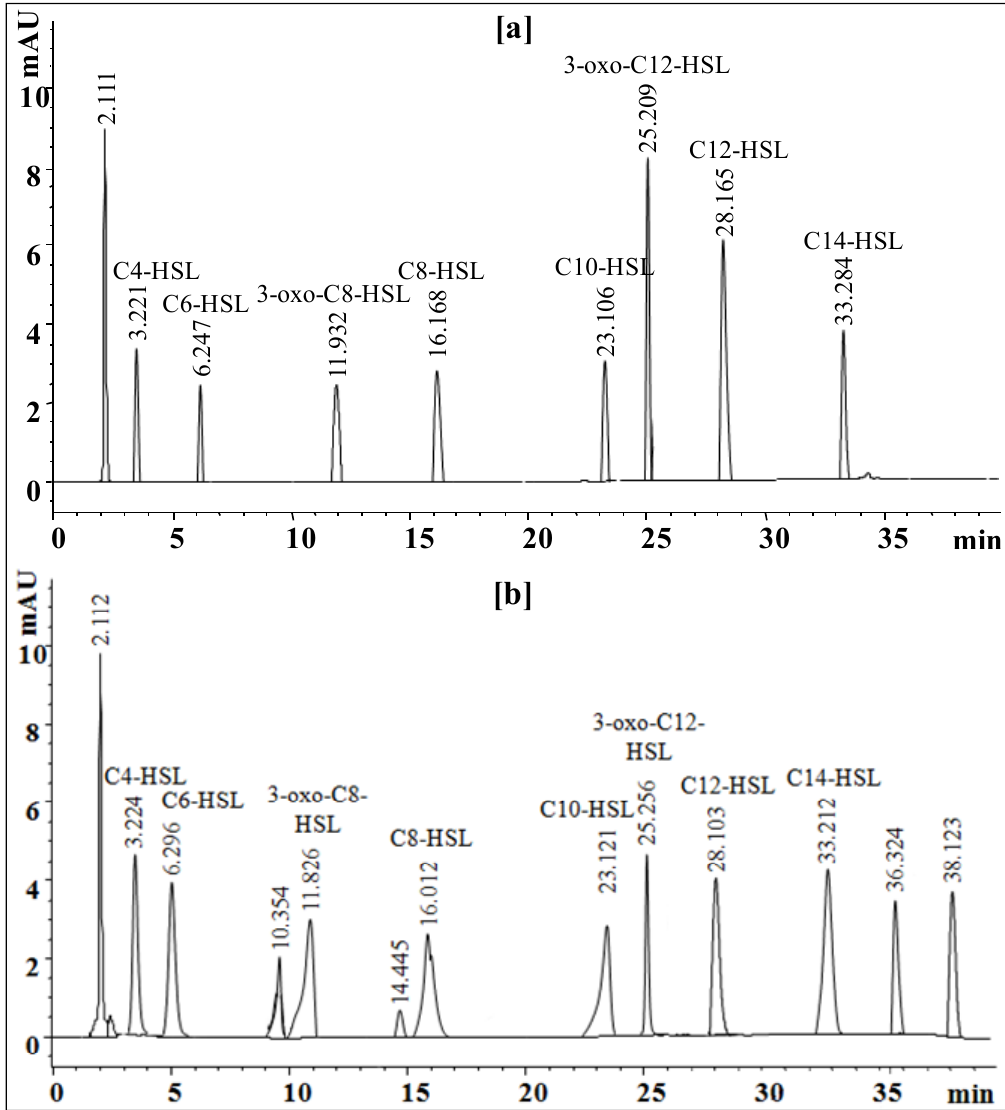
Figure 7. Identification of the AHLs extracted from MBR activated sludge by HPLC. ( a ) Chromatogram showing the retention times of standard AHLs each at 50 µg/mL concentration in a mixture of C4-HSL, C6-HSL, C8-HSL, 3-oxo-C8-HSL, C10-HSL, C12-HSL, 3-oxo-C12-HSL and C14-HSL; ( b ) The sludge AHLs were identified by comparing appeared peaks retention time with those of respective standard